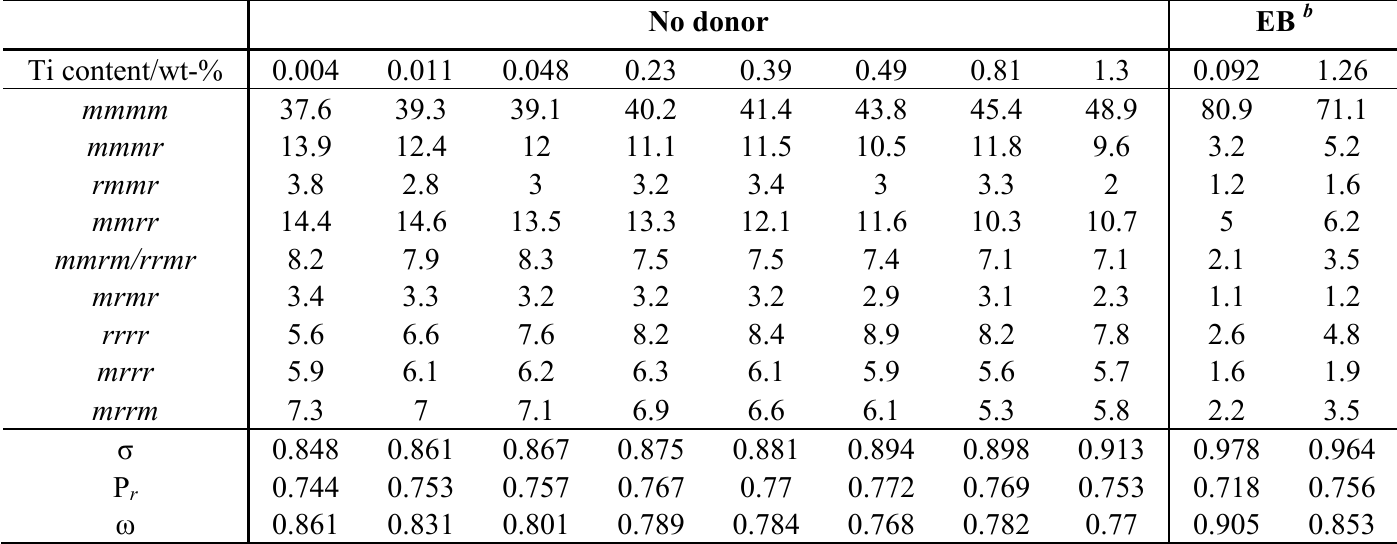
Table 1. Pentad stereosequences (in mol%) and fitting results for whole PPs a